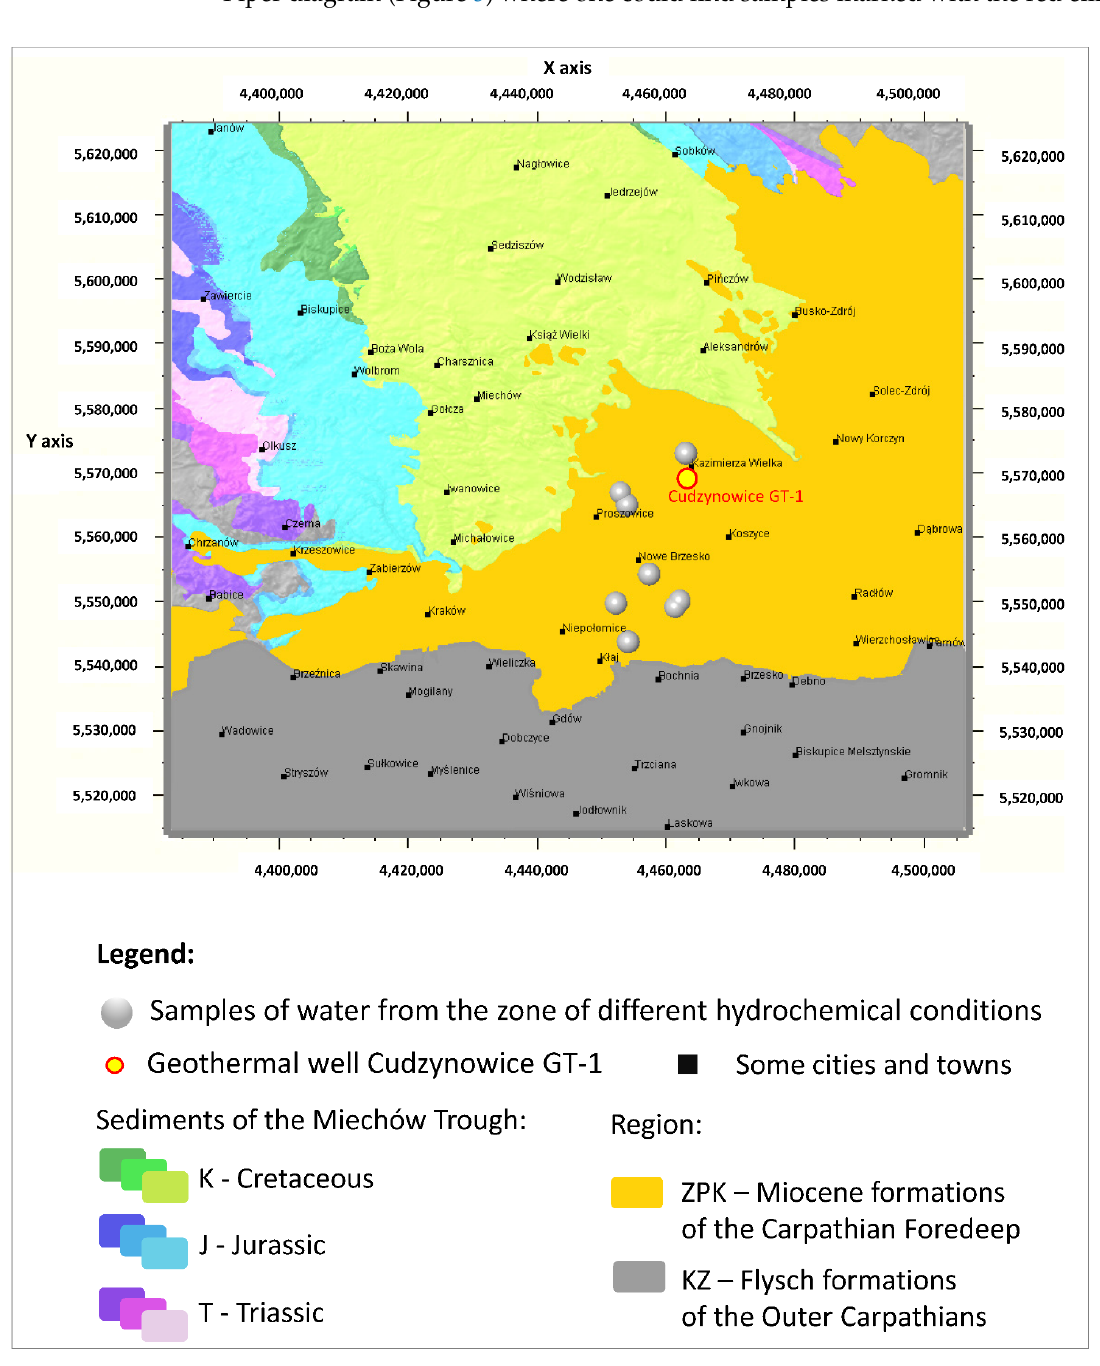
Figure 14. Location of the zones of different hydrochemical conditions on the background of the geological map of the analyzed area.